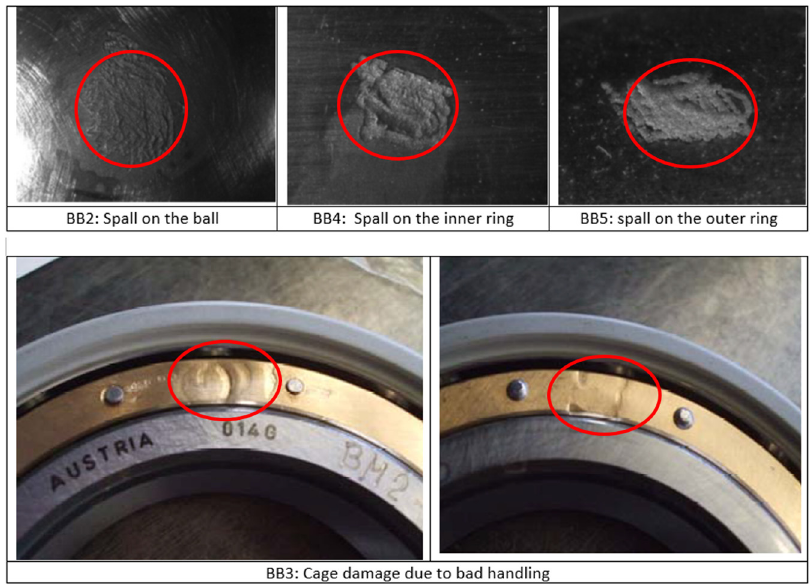
Figure 10. Different types of seeded defects of ball bearings (case study-2). Table 4. Bearings defect classes considered in case